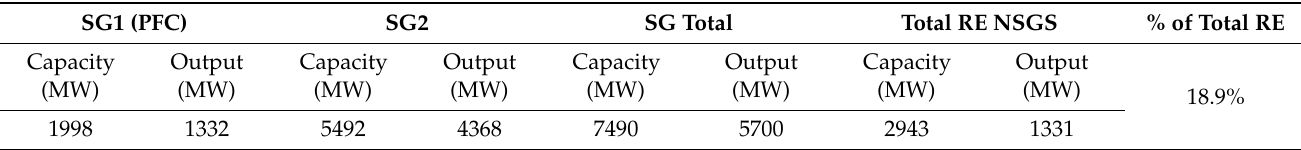
Table 1. Generation parameters of the modelled QLD power system during the separation event [28].